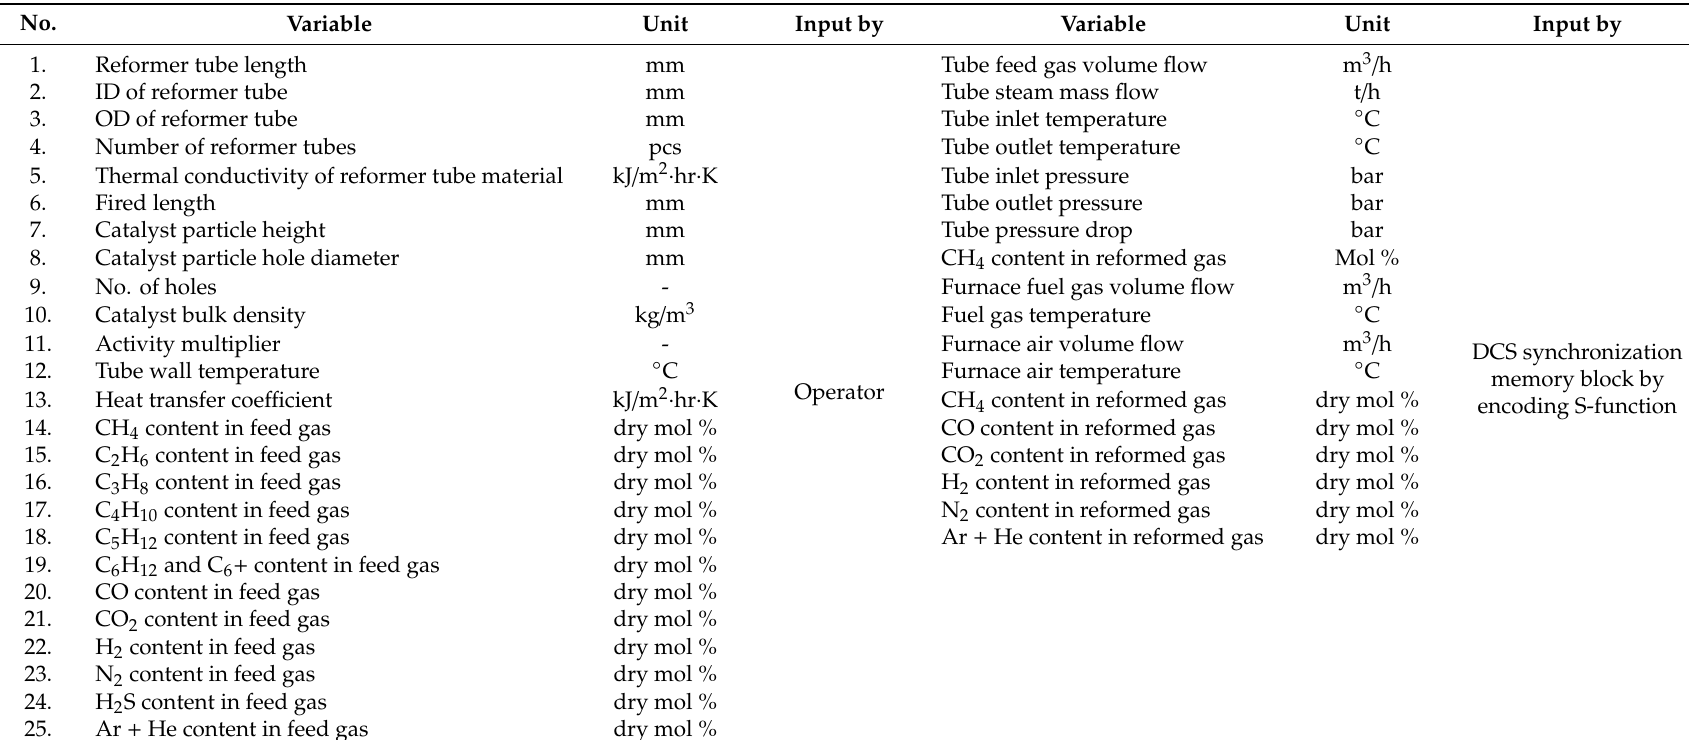
Table 2. List of variables for monitoring and evaluation of the SMR